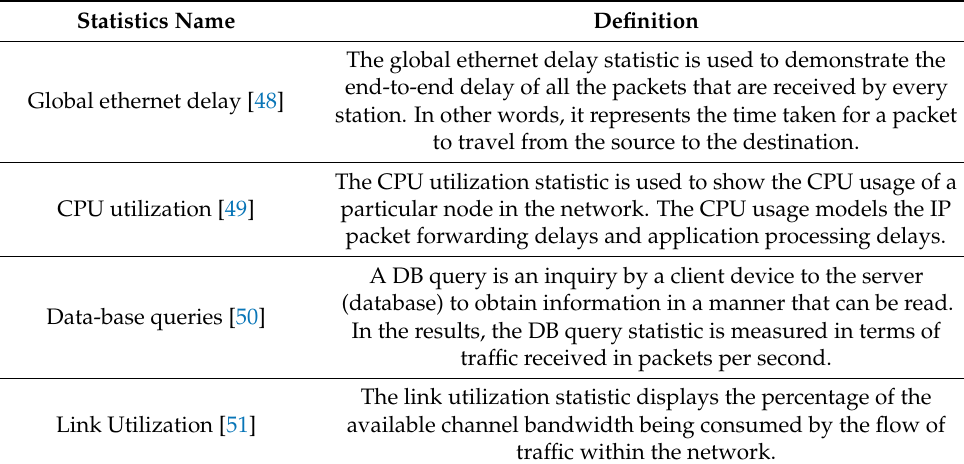
Table 3. Analysed statistics for system